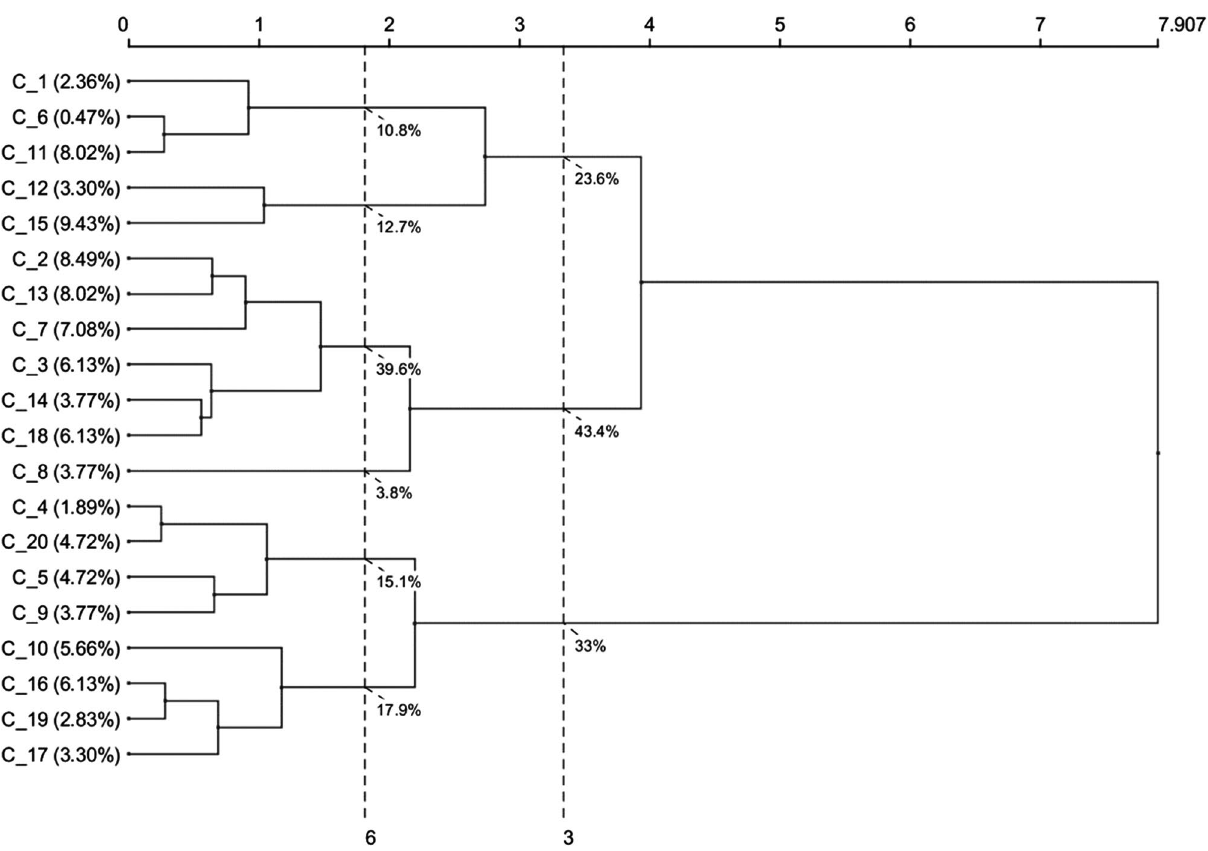
Figure 2. Dendogram using Ward’s